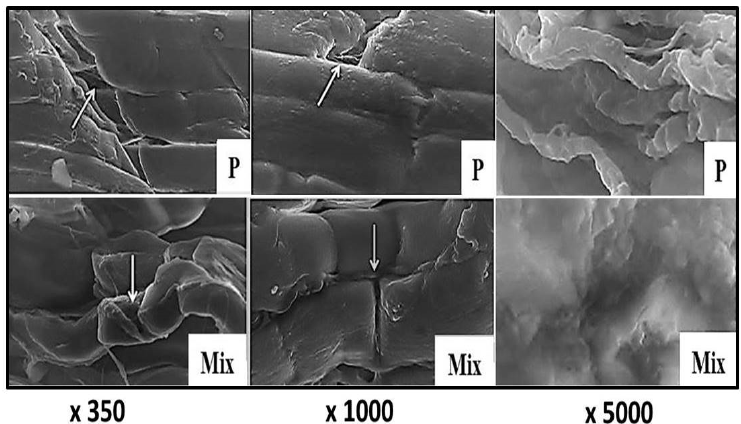
Figure 6. Scanning electron micrographs of camel semitendinosus muscle (×350, ×1000, and ×5000). P: papain-enzyme powder; M: a mixture of ginger and papain. White arrows point to fragmented muscle fibers.